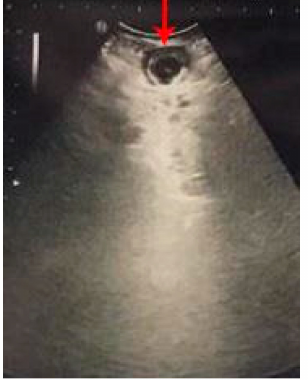
Figure 6. Target sign (red